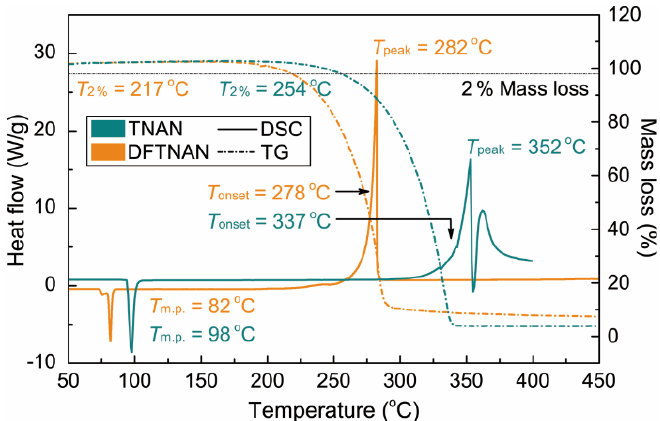
Figure 2. DSC and TG curves of the decomposition processes of DFTNAN and TNAN.